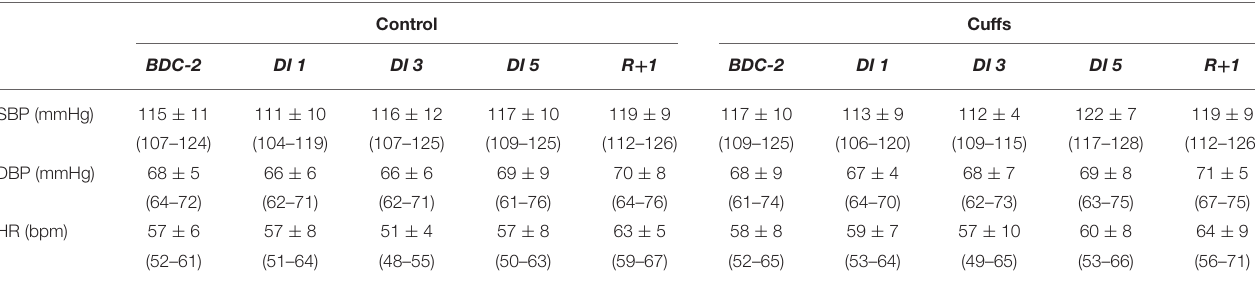
TABLE 2 | General hemodynamic parameters.